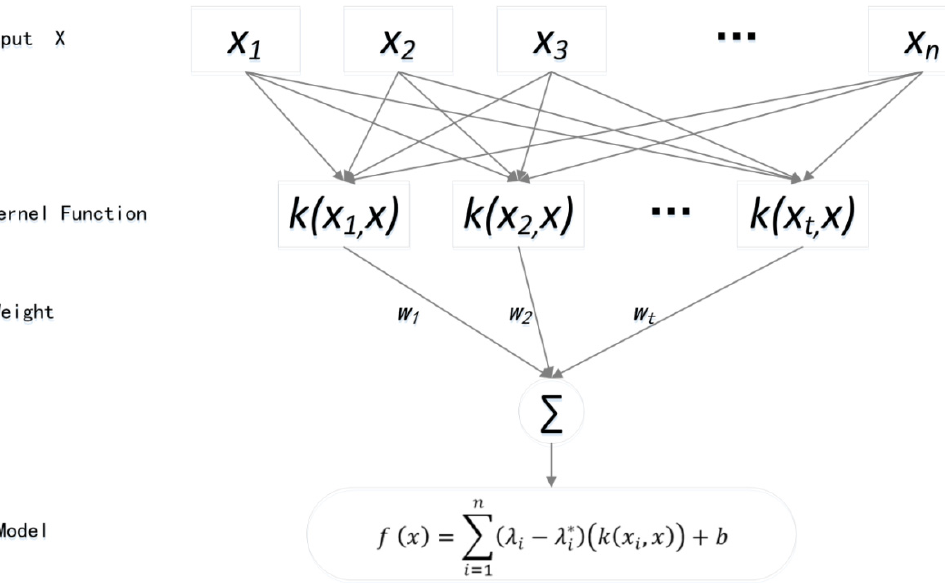
Figure 3. Flow chart for the support vector machine (SVM) algorithm.